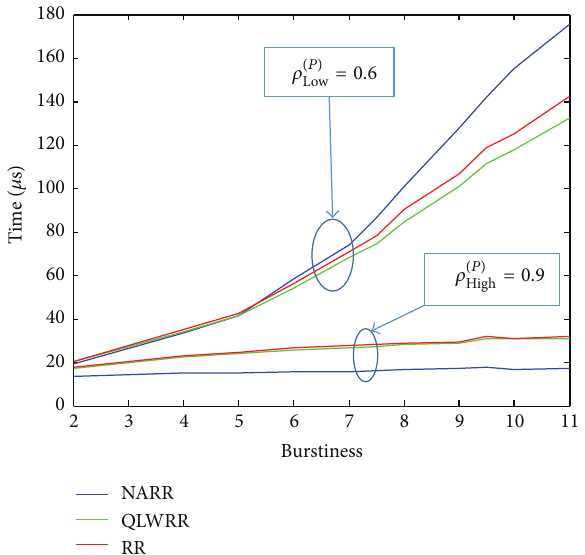
Figure 9: Mean delay in the function internal queues.